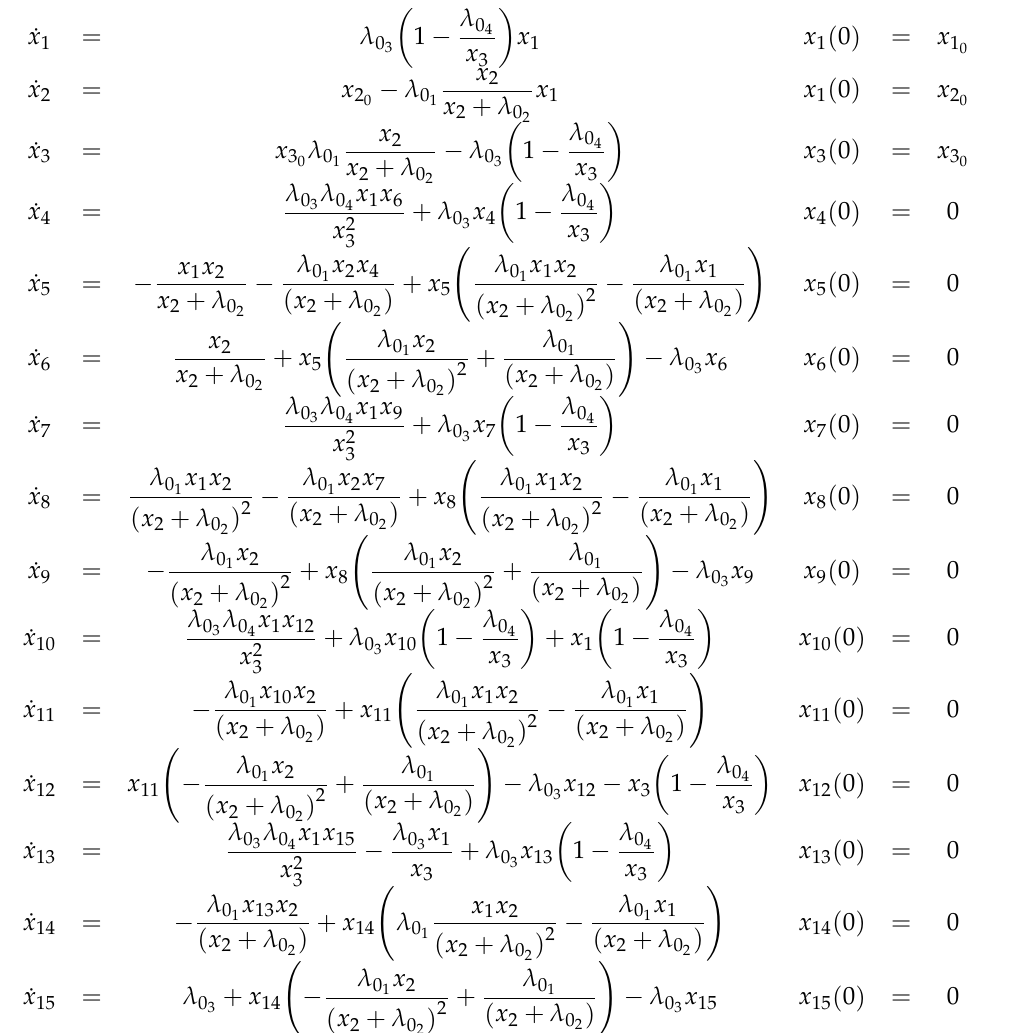
= 0.1 mgN ( mgC ) − 1 d − 1 , λ 1